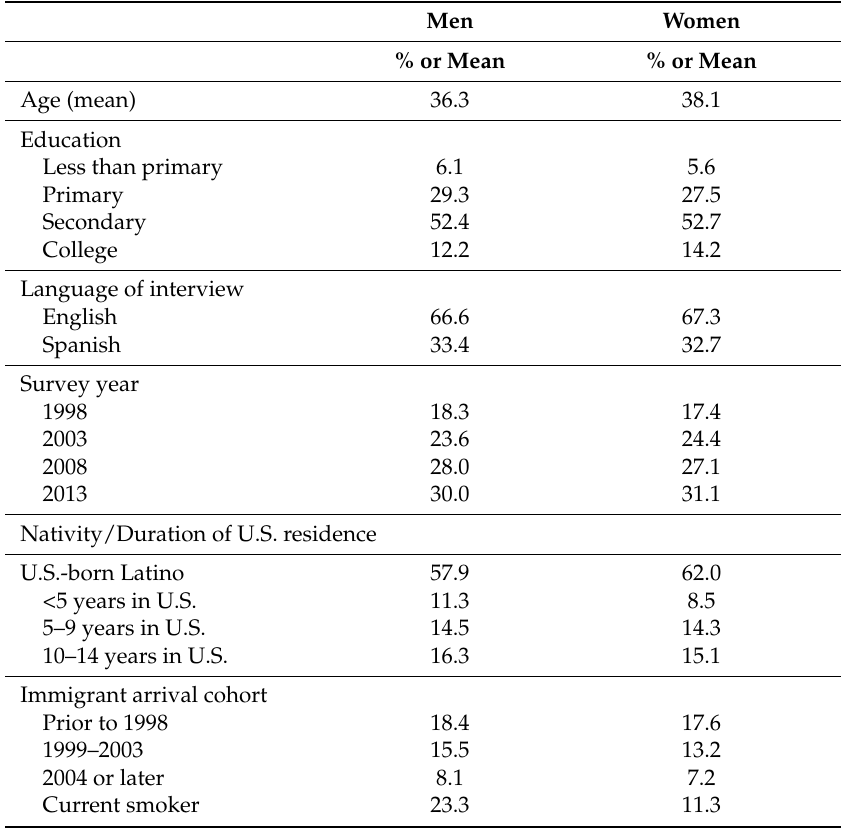
Table 1. Weighted sample characteristics by gender: U.S. Latinos, 1998–2013. Men Women % or Mean % or Mean 36.3